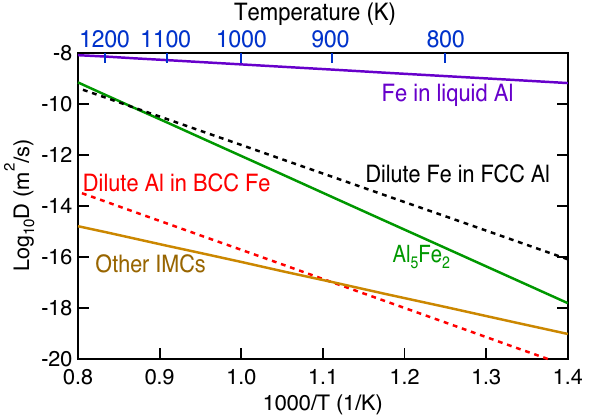
Figure 7. Diffusion coefficients of Fe in liquid Al 58 , dilute Fe in FCC Al 58 , dilute Al in BCC Fe 59 , and the elements in Al 5 Fe 2 and other IMCs (AlFe, Al 2 Fe, and Al 13 Fe 4 ) 42 .